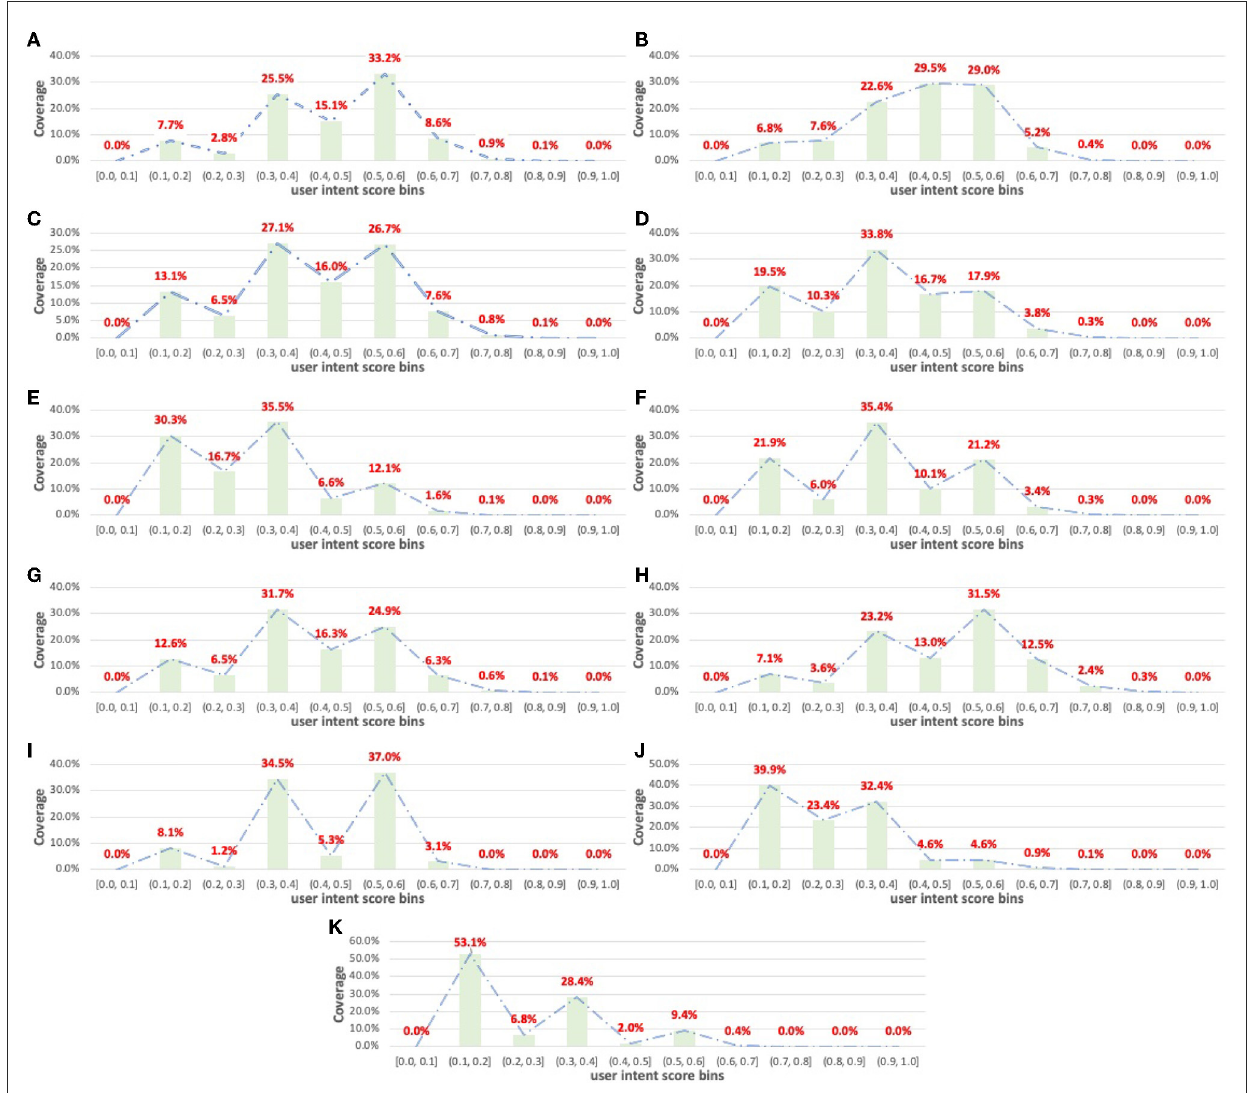
FIGURE3 Distribution of user intent scores by departments. (A) Deli, (B) Produce, (C) Dair eggs, (D) Beverage, (E) Meat seafood, (F) Canned goods, (G) Frozen, (H) Bakery, (I) Breakfast, (J) Pantry, and (K)